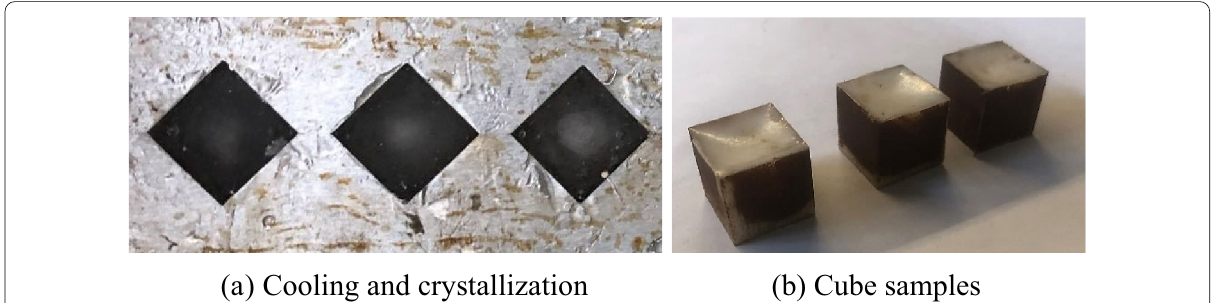
Fig. 3 Sample preparation of PCL